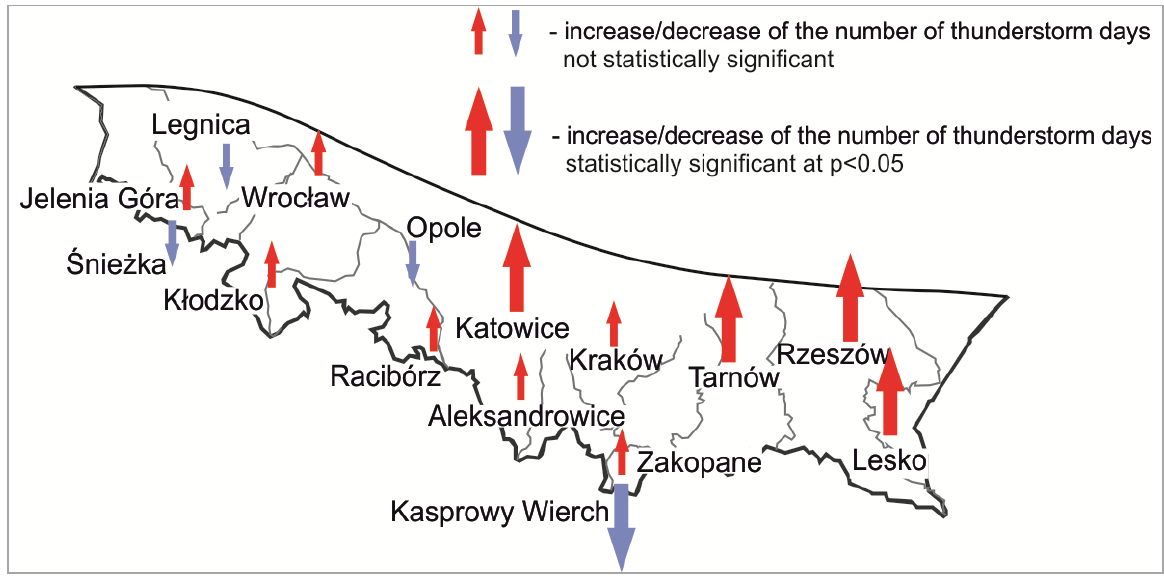
Fig. 5. Tendency of the annual number of the thunderstorm days occurrence in the period 1951-2010 Table 5. Tendency [days/10 years] of the thunderstorm days and certain daily sums of precipitation occurrence on the days with thunderstorm in the period 1951-2010